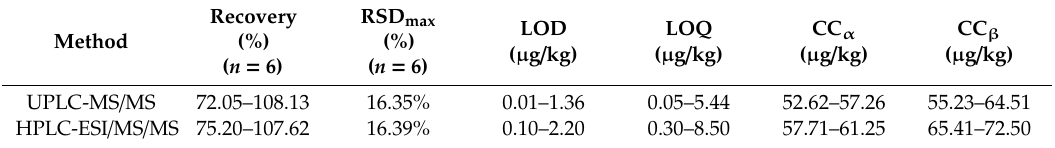
Table 8. Comparison of HPLC-ESI / MS / MS and UPLC-MS / MS verification